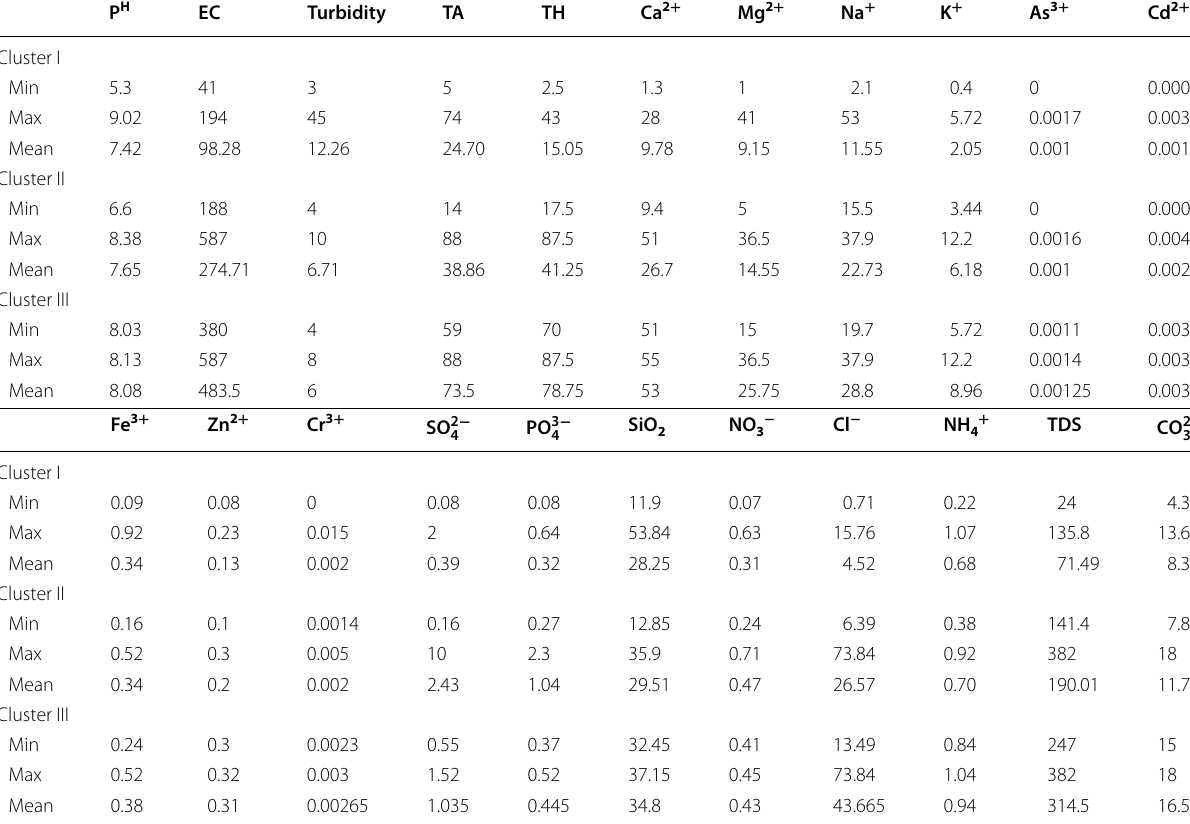
Table 6 Physico-chemical parameters of different clustered